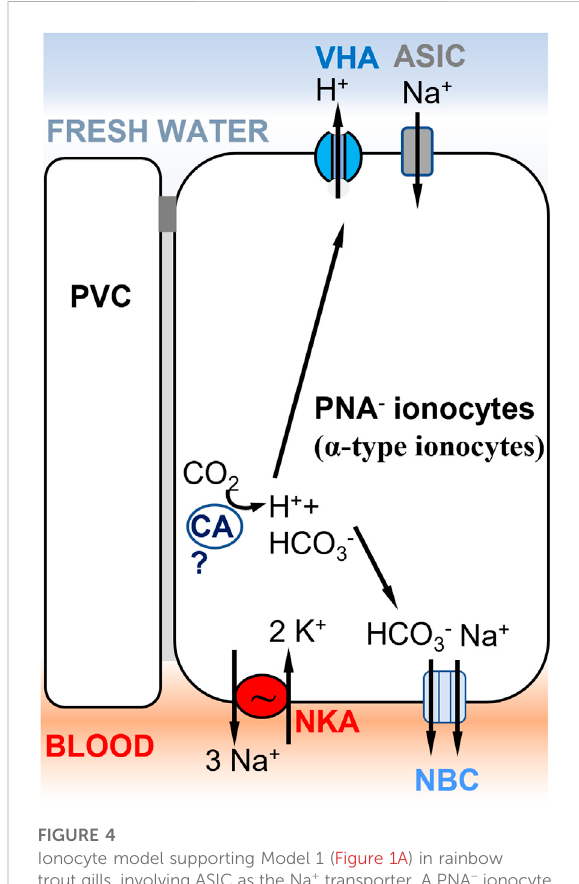
FIGURE 4 Ionocyte model supporting Model 1 (Figure 1A) in rainbow trout gills, involving ASIC as the Na + transporter. A PNA − ionocyte model (Zimmer et al., 2017) with apical VHA (Lin et al., 1994) electrogenically coupled to a Na + channel, which has been identi fi edas ASIC-4 by Dymowska etal. (2014). PNA − ionocytes do not express NHE2/NHE3 and do not express Rh transporters. A basolateral electrogenic NBC transporter (3? HCO 3 − : 1 Na + ) has been shown to be present by Parks et al. (2007). The presence of a cytoplasmic carbonic anhydrase (CA) is hypothesized to support acidsecretionintroutgills,but evidenceofthespeci fi cCAparalog expressed in this cell type is lacking (Georgalis et al., 2006). PVC= pavement